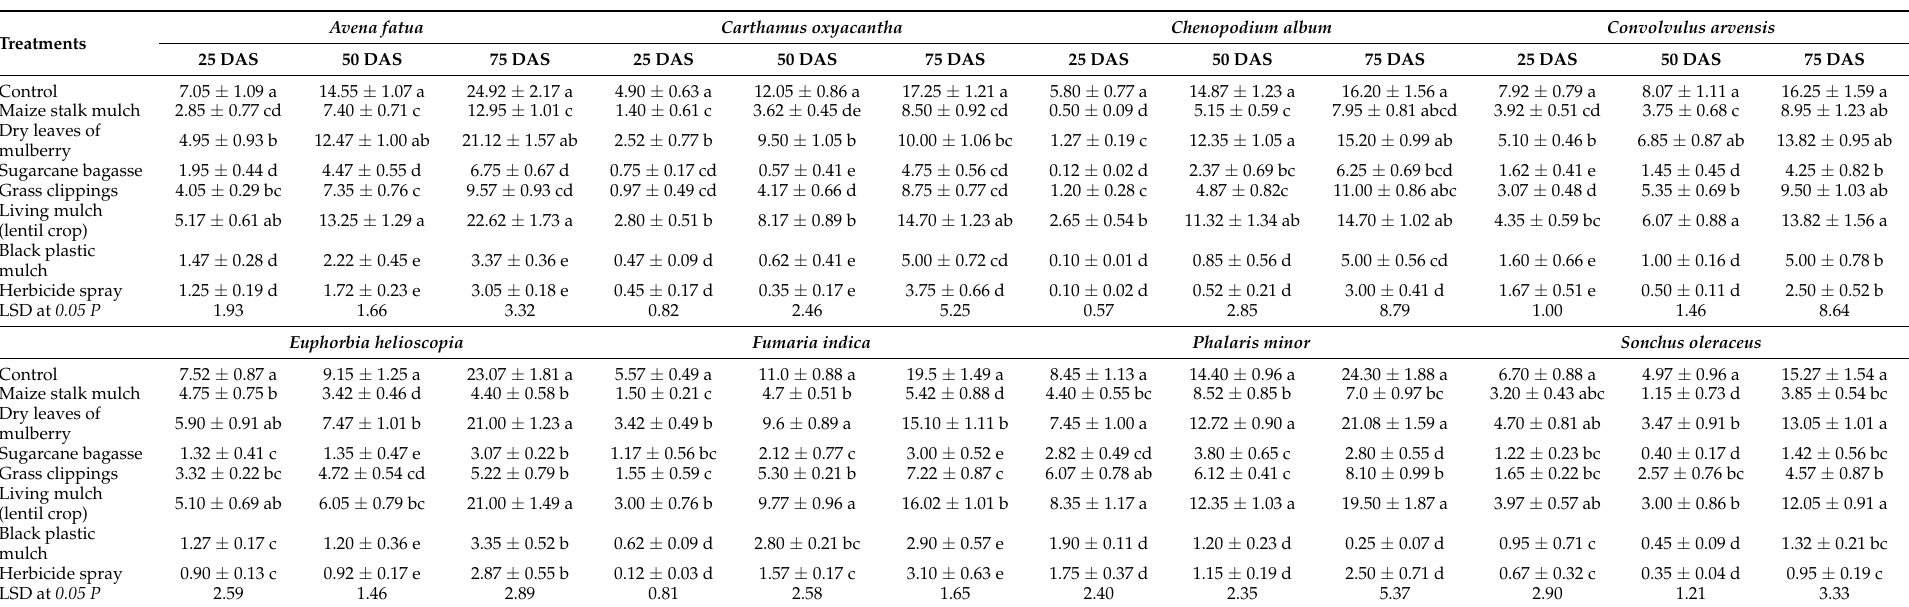
Table 3. Effect of mulch materials on fresh biomass (g) of different weed species of